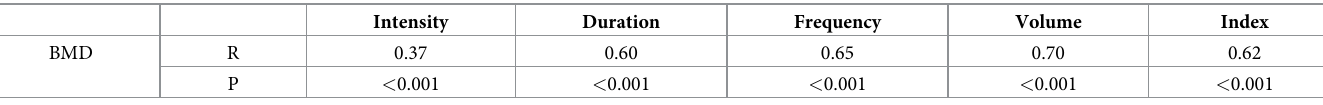
Table 2. Correlations between BMD and intensity, duration, frequency, volume and